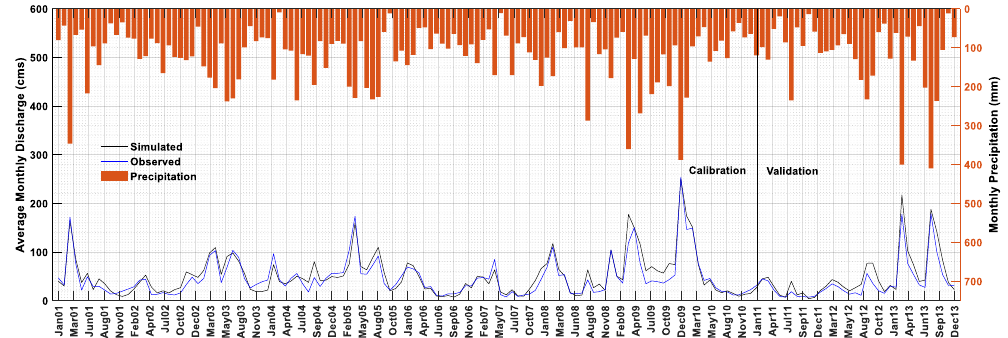
Table 5. Model efficiency evaluation metrics.